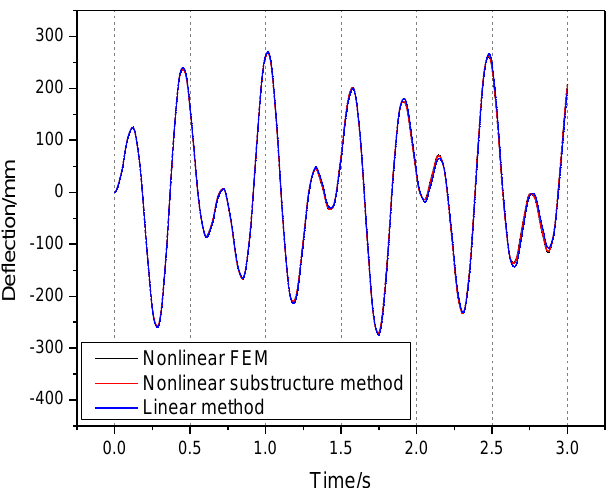
Figure 10. Dynamic transient analysis results with F 0 = 7 N and f = 2 Hz.